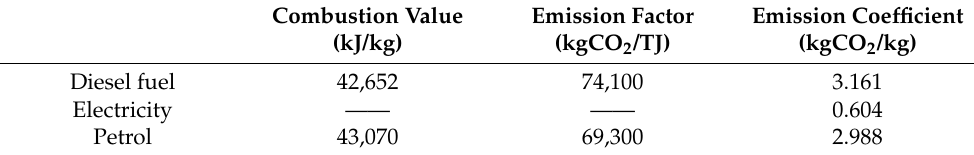
Table 3. Carbon dioxide emission coefficient of various energy